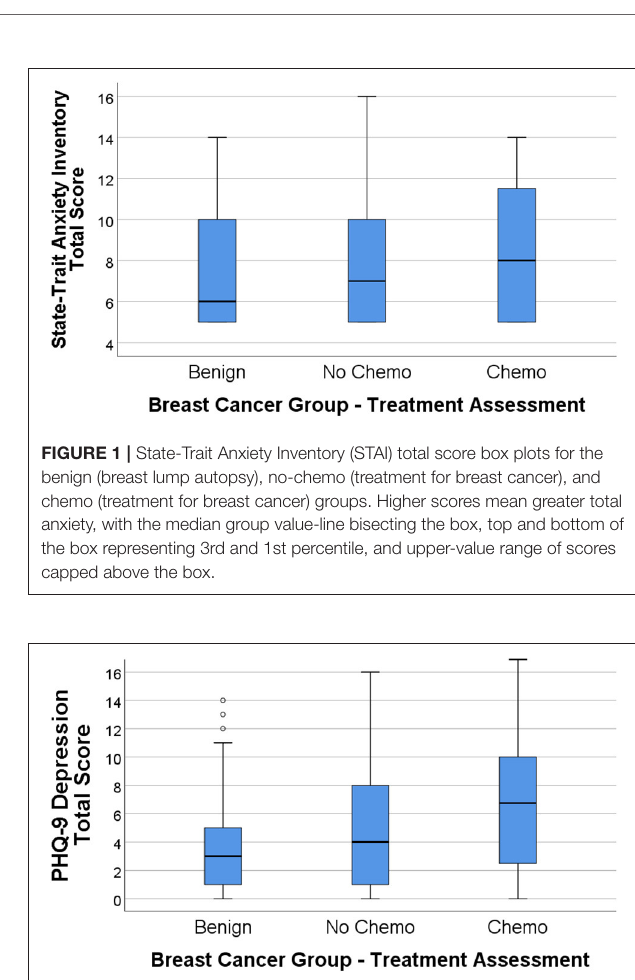
treatment group was noticeably worse (lower scores) on all the QoL domains ( Figure 3 ) and the CogState performance tests ( Figure 4 ) compared with the no chemotherapy breast cancer and benign biopsy (no breast cancer)